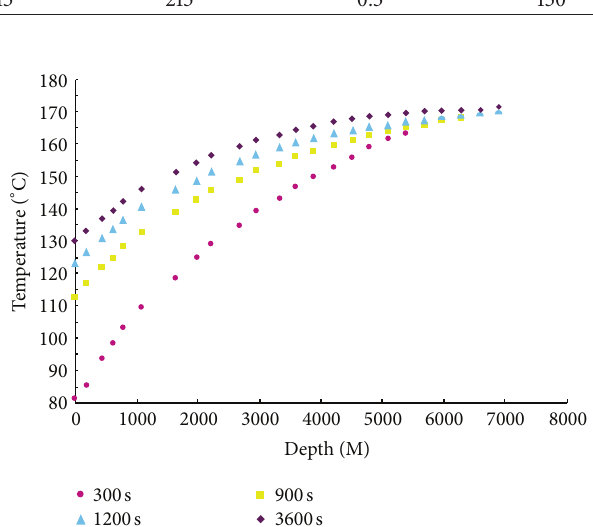
Figure 6: Temperature distribution at different depths.